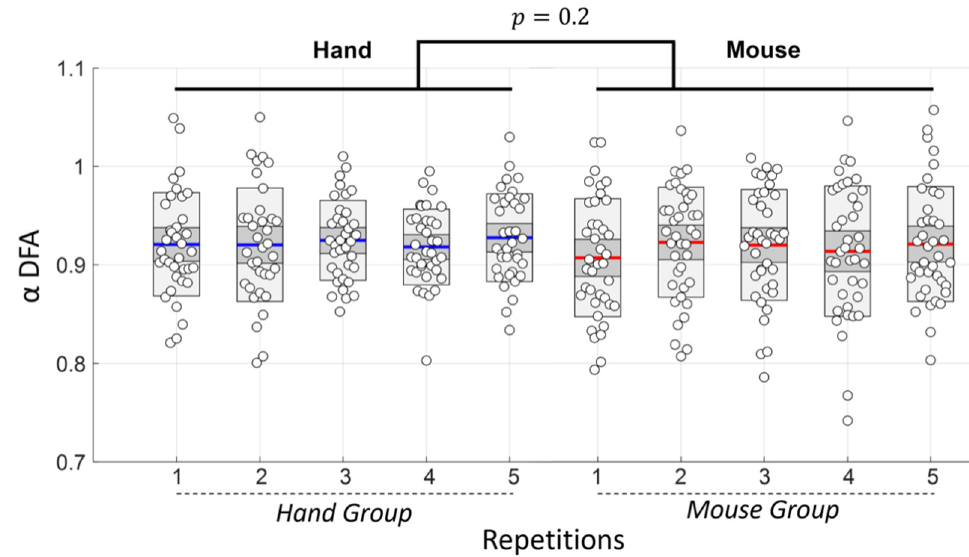
Figure 4. Hand and mouse conditions compared by using a monofractal formalism. Colored lines indicate mean, heavy grey ±1SD and light gray 95% confidence interval. Individual values are represented by white circles.